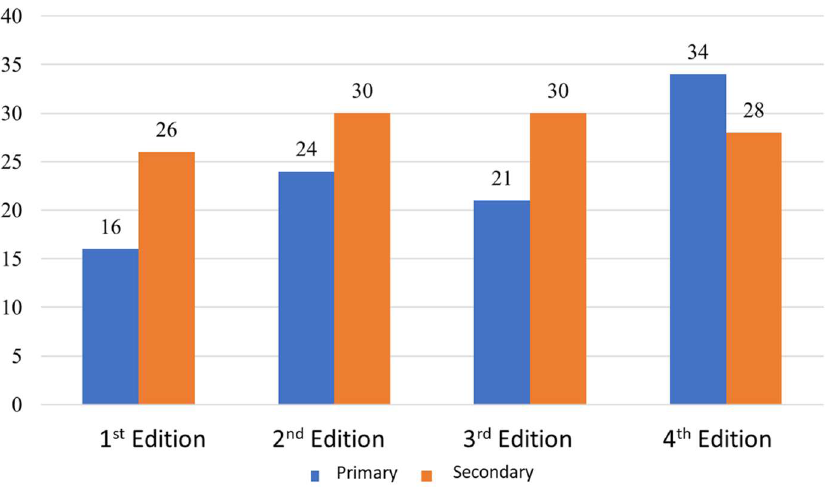
Figure 8. Evolution of students’ work presented per edition, Source: Own elaboration.